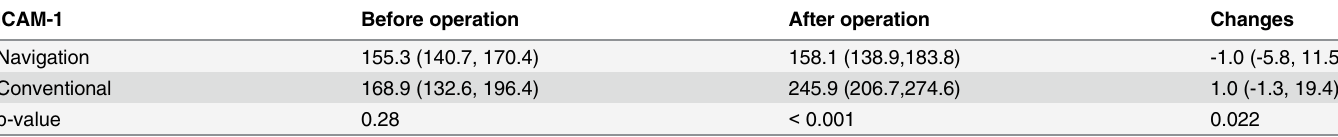
Table 2. Serum concentrations of ICAM-1(unit: ng/mL) in patients before and after navigation and conventional TKAs, and the changes from pre- operative baseline after surgery (post-OP — pre-OP).